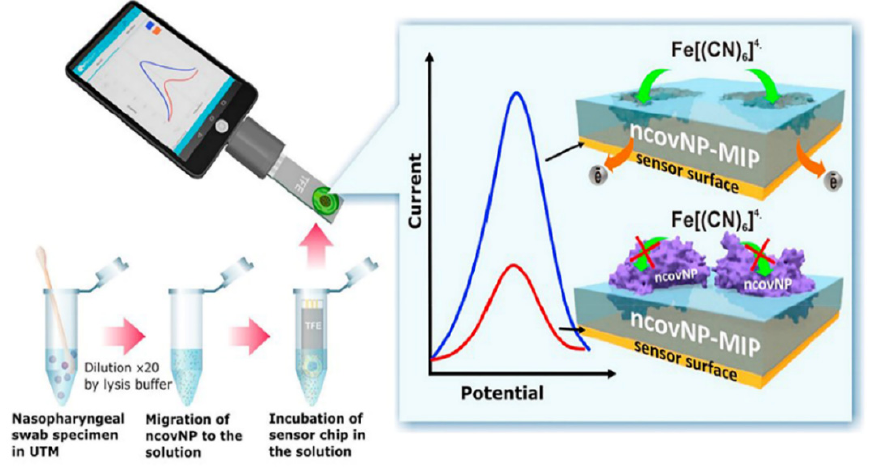
Figure 11. MIP-sensor for COVID-19 diagnosis (ncovNP detection). Principle of diagnosis and detection. Reproduced with permission from [31]. Copyright 2021, Elsevier.